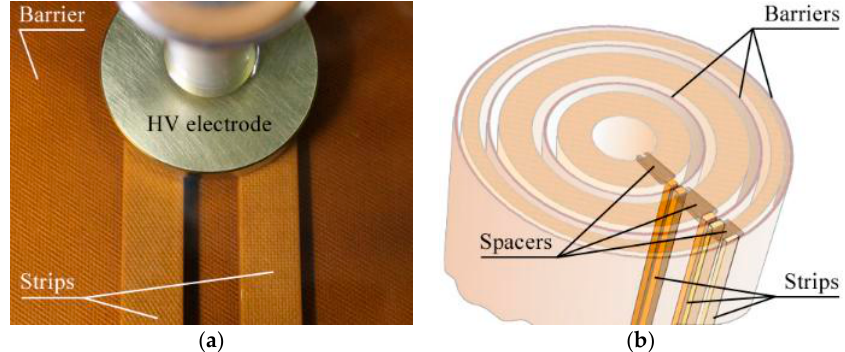
Figure 7. ( a ) Schematic diagram of the transformer paper-oil insulation system; and ( b ) arrangement of the insulation samples used in the experiment.